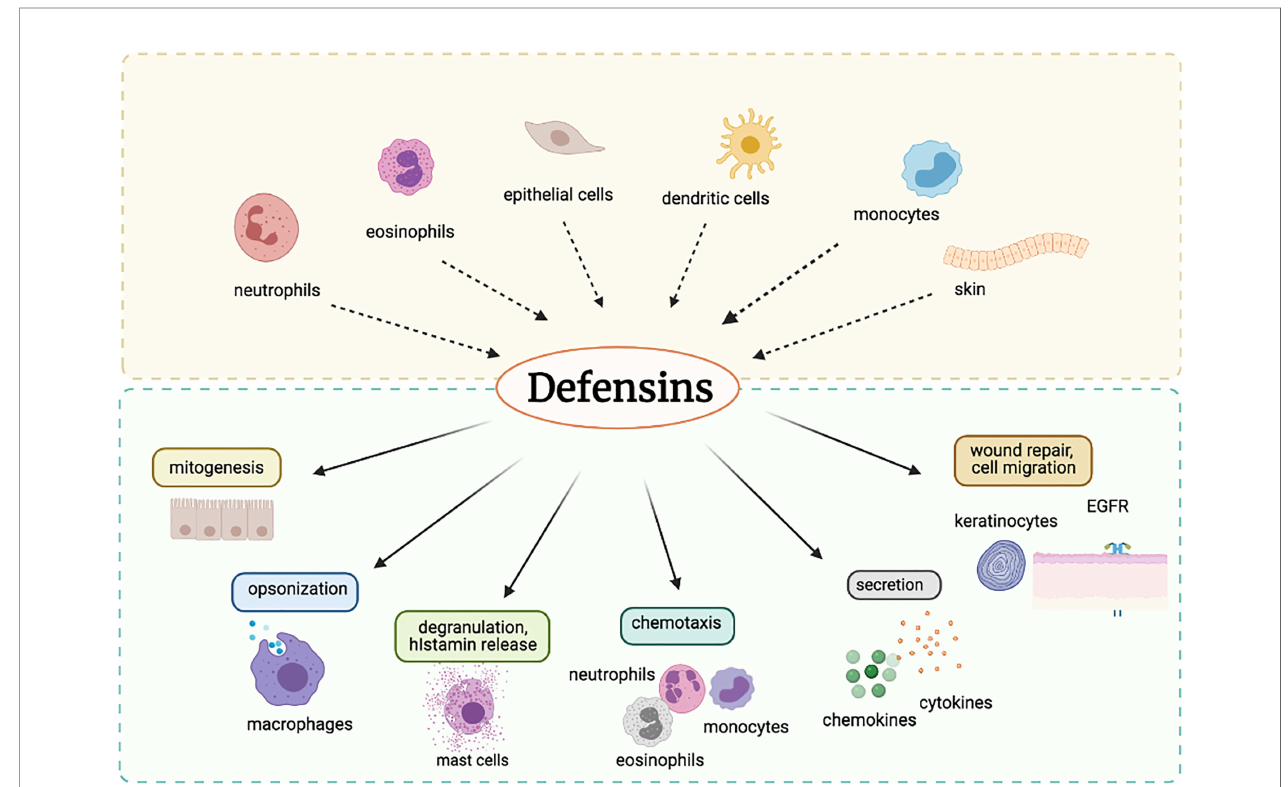
FIGURE 1 | A schematic diagram for the role of defensins in the host immune